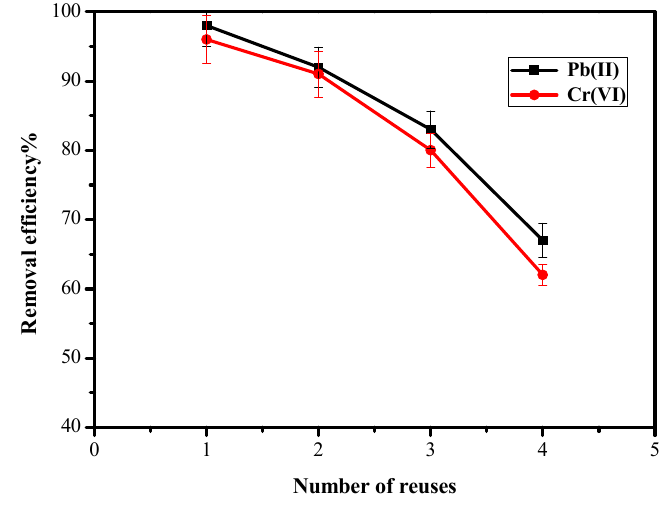
Figure 9. AAJPL reactivation and